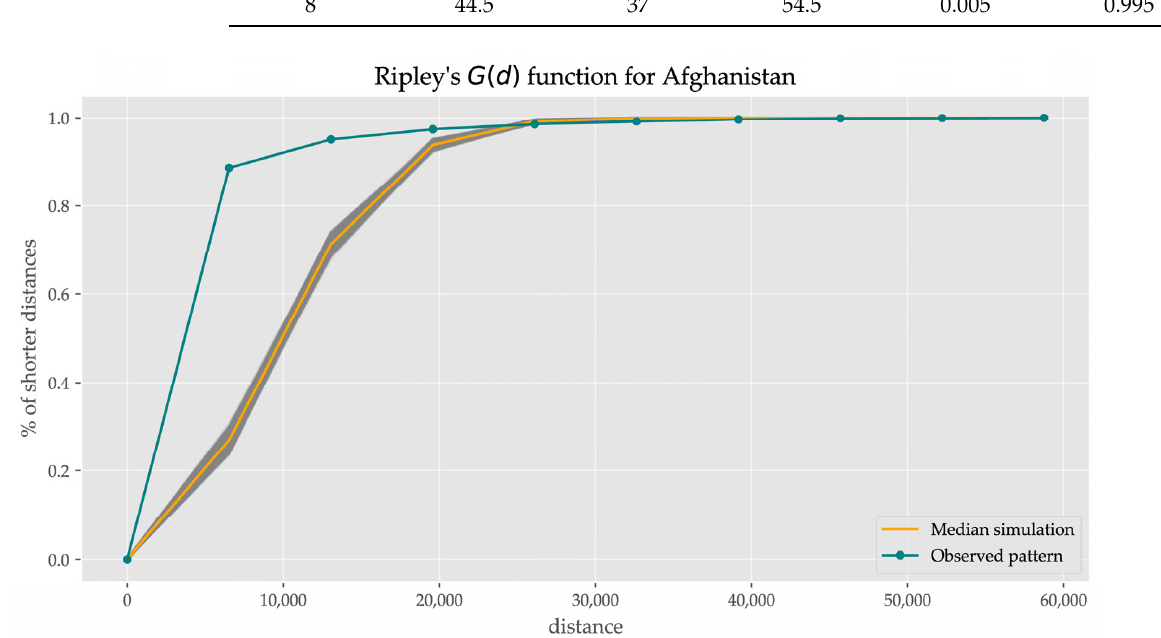
Figure 7. Ripley’s G(d) function for